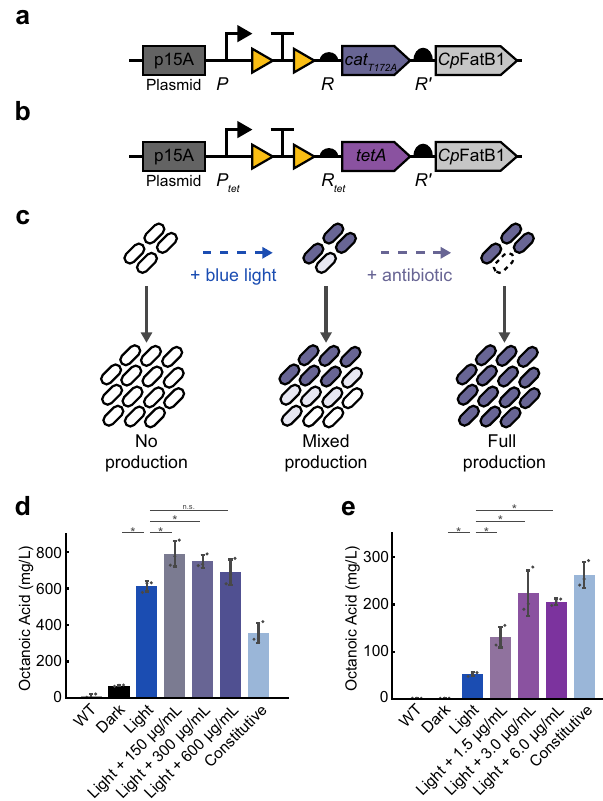
Fig. 6 | Light-inducibleproductionofoctanoic acid. a Activation of OptoCre- cat using cat T172A or b OptoCre- tetA is coupled with Cp FatB1 by introducing the gene downstream of the drug resistance marker under the strong RBS R ’ . c Blue light induces expression of the resistance gene and Cp FatB1, but does not guarantee all individuals within a community are expressing the genes. Non-producers have a growth advantage due to the burden of Cp FatB1. Addition of chloramphenicol prevents growth of any individuals not producing the resistance gene and conse- quently Cp FatB1. d Octanoic acid production coupled with OptoCre- cat measured byGC-MS. e OctanoicacidproductioncoupledwithOptoCre- tetA measuredbyGC- MS.Signi fi cancewasdeterminedusingatwo-tailedWelch ’ st-test:* P <0.05;n.s.not signi fi cant. Error bars show standard deviation around the mean ( n =3 biological